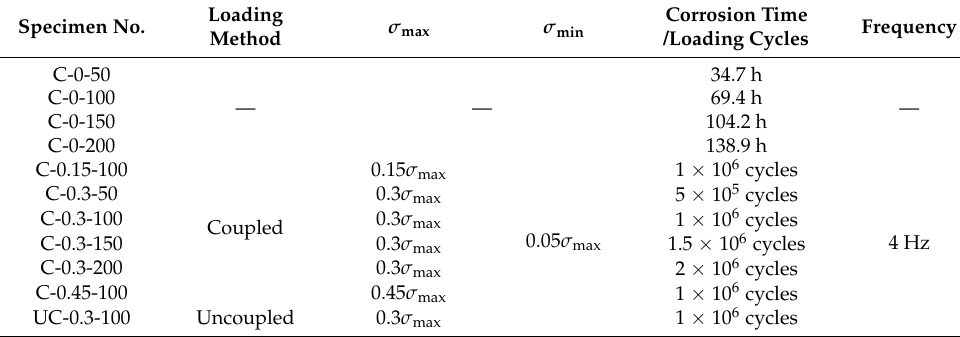
Table 2. Statistical table of repeated loading conditions under uniaxial compression.